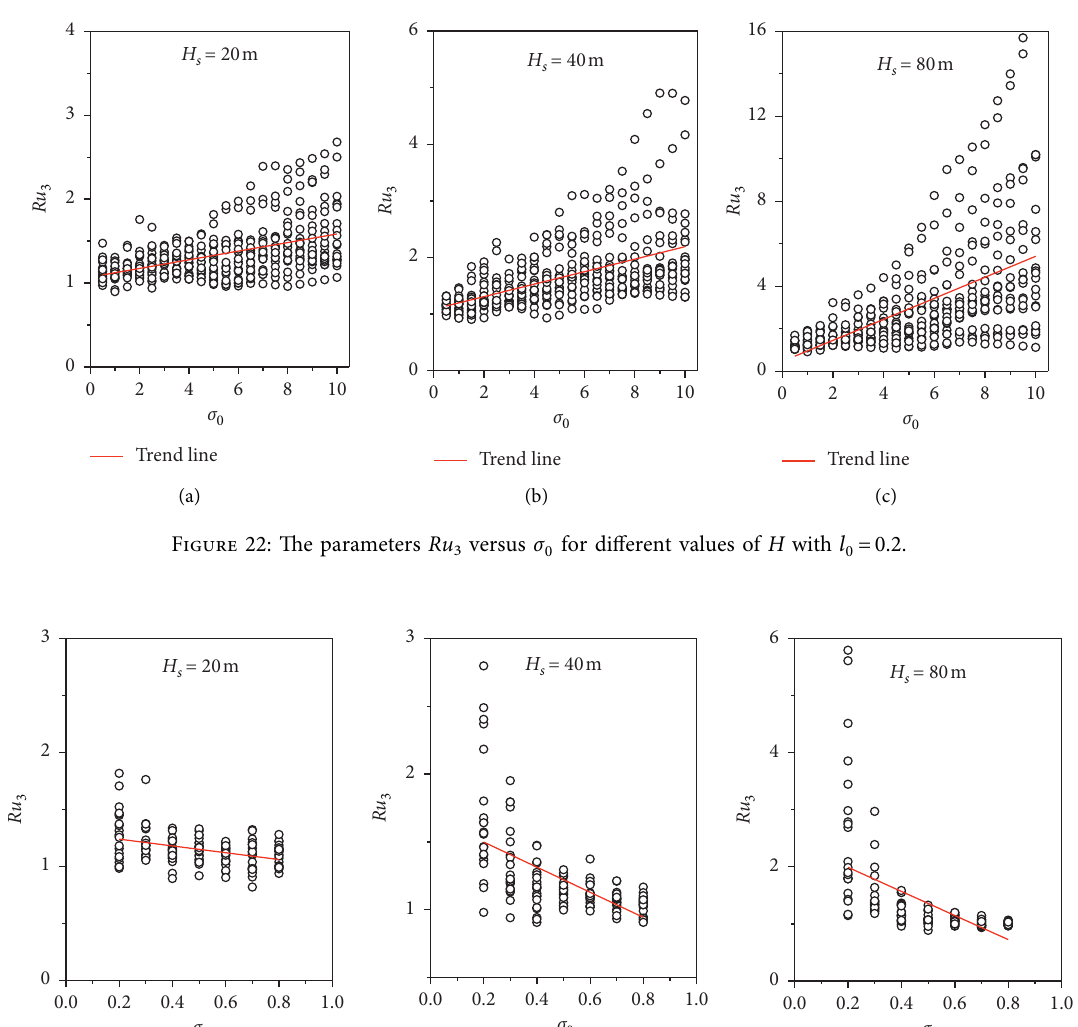
Figure 23: The parameters Ru